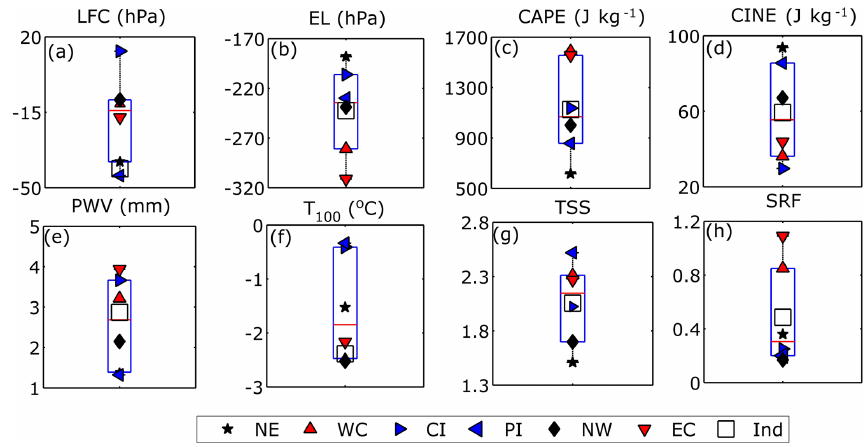
Figure 5. Long-term variation of (a) LFC, (b) EL, (c) CAPE, (d) CINE, (e) PWV, (f) T 100, (g) TSS, and (h) SRF over the six subdivisions of India during the period 1980–2016. Legends are the same as in Fig.